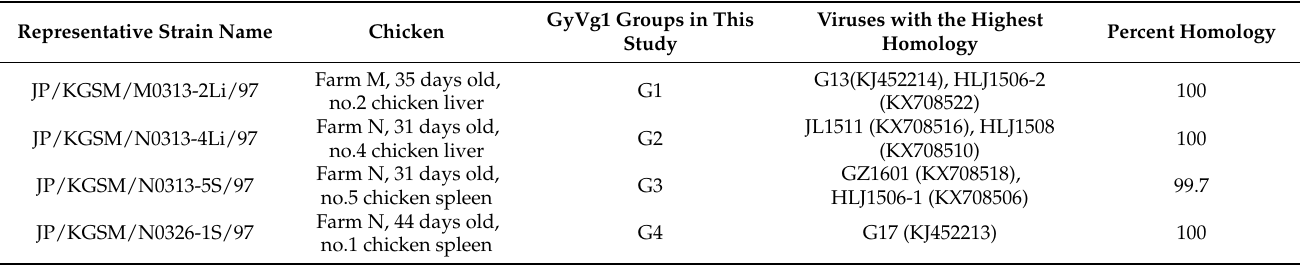
Figure 2. Phylogenetic trees based on the partial gene of GyVg1 strain G13 (GenBank accession no. KJ452214). Nucleotides 678–978 were subjected to phylogenetic analysis. Subsequently, a tree was generated using the neighbor-joining method in MEGA 7 [17] with 1000 bootstrap replicates. All tools were run with default parameters unless otherwise specified. Then, horizontal distances were proportionally set to the minimum number of nucleotide differences required to join nodes and sequences. The Japanese GyVg1 strains are indicated by black circles. Table 3. Genetic comparison of nucleotide sequences of PCR products detected in first screening PCR by GenBank